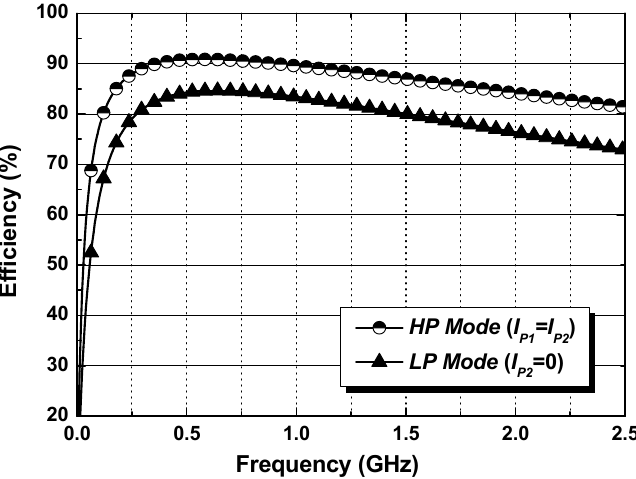
Figure 2. Calculated transformer efficiencies for HP and LP modes for the PCT.